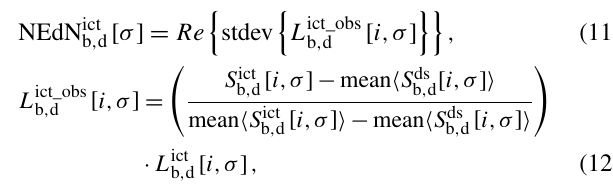
(NEdT) are plotted in Fig. 13 with the blackbody tempera- ture trend within a one-revisit time period. The upper panel